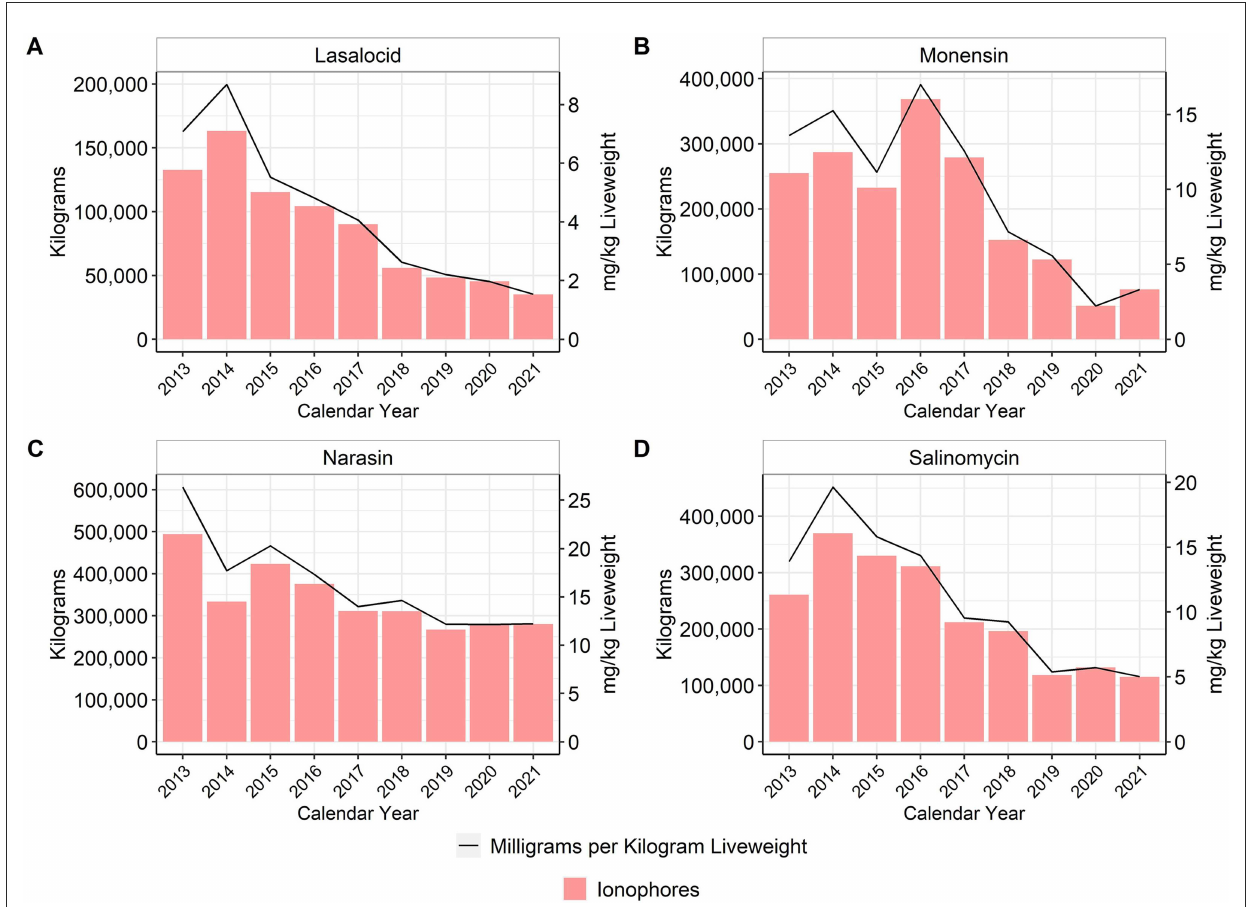
FIGURE3 Lasalocid (A) , monensin (B) , narasin (C) , and salinomycin (D) used in broiler feed, 2013–2021. Total kilograms are shown by the bars (left Y-axis) and total mg/kg liveweight are shown by the line (right